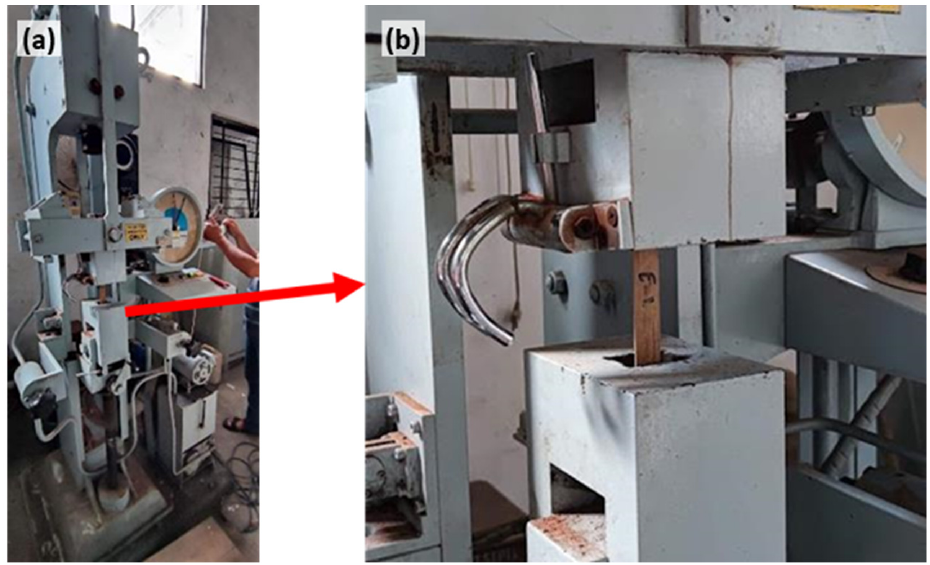
Figure 6. ( a ) Universal testing machine for the tensile test of bamboo and ( b ) the bamboo specimen during the tensile test.